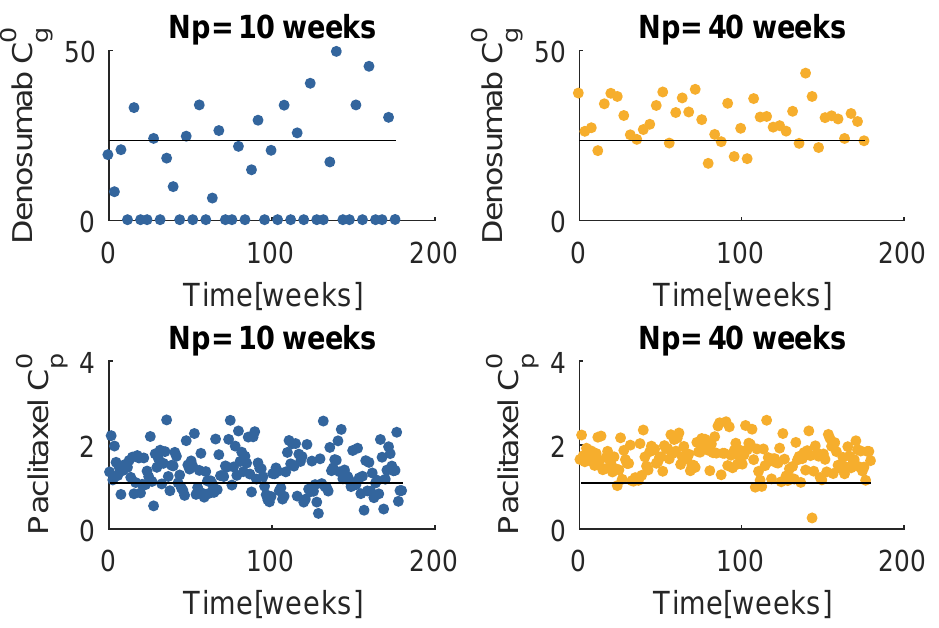
Figure 8. Best obtained prescriptions in mg with the model M DR 1